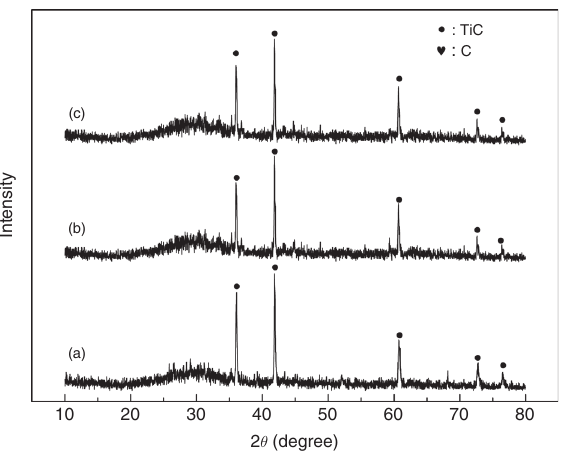
Figure 13: XRD results of reduced samples at 1,773 K, 4 h for different carbon ratio: (a) 0.7; (b) 0.85; (c) 1.0.